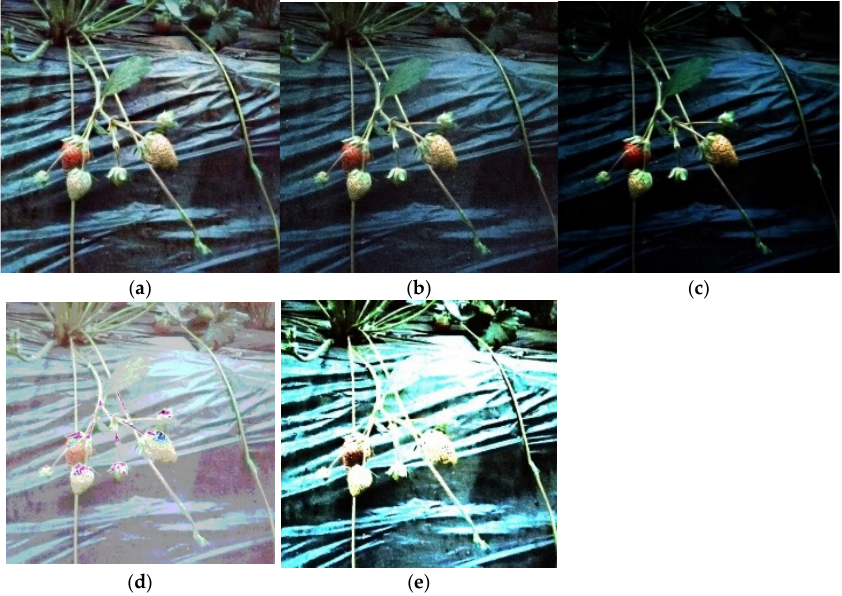
Figure 4. Enhanced image effect. ( a ) Histogram equalization; ( b ) Laplace transform; ( c ) Gamma transform; ( d ) Log transform; ( e ) Dark channel enhancement.